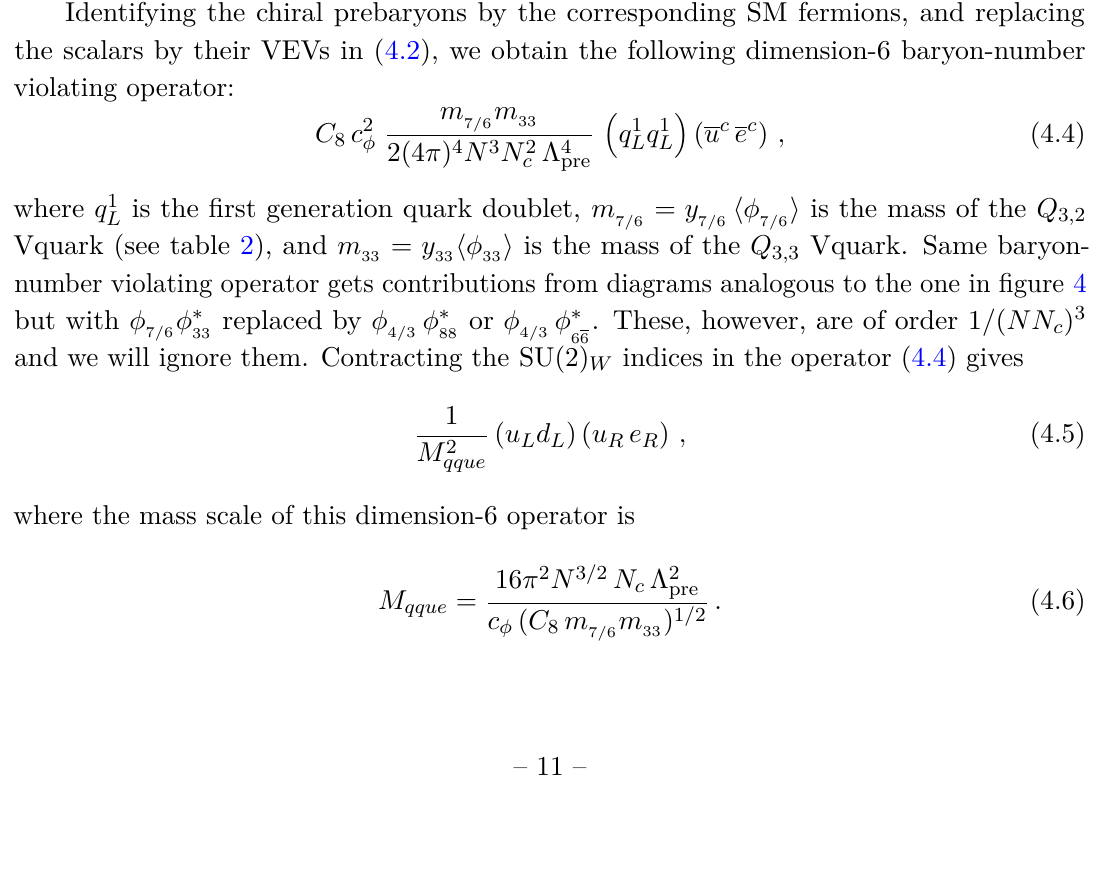
and φ are 33 7 / 6